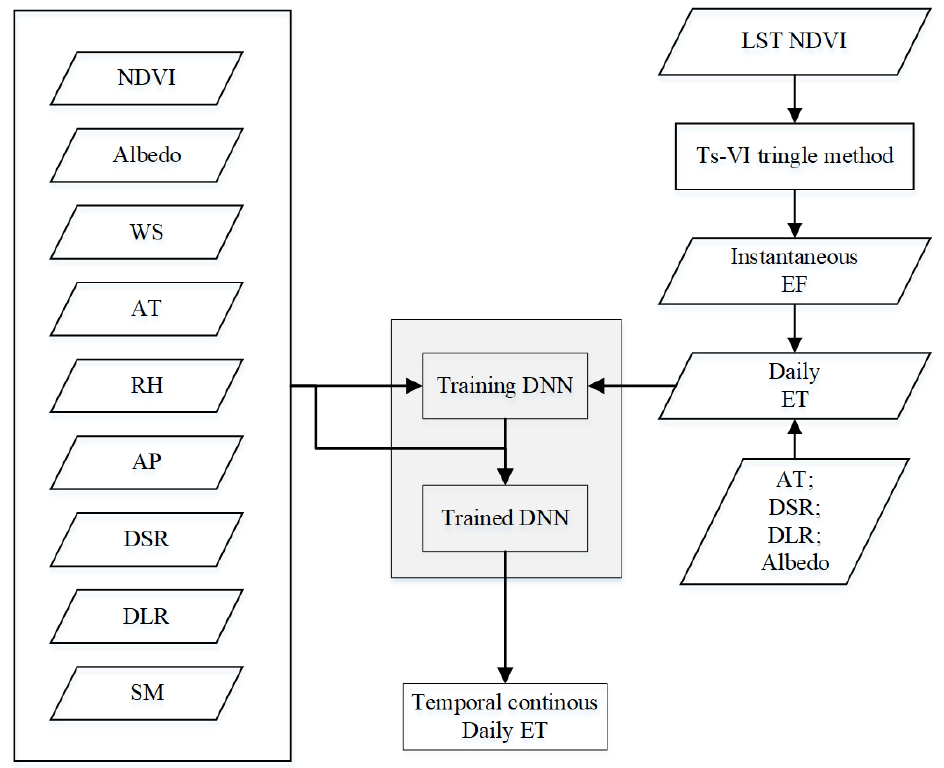
Figure 2. Flowchart for obtaining temporal continuous daily actual evapotranspiration based on the Ts-VI triangle method and the deep the neural network. Where WS: wind speed; AT: air temperature; RH: relative humidity; AP: air pressure; DSR: downward shortwave radiation; DLR: downward longwave radiation; SM: soil moisture; Ts-VI: surface temperature-vegetation index; DNN: deep neural network.